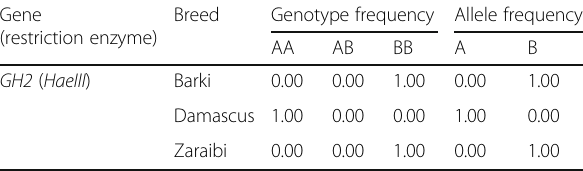
Table 3 Genotype and allele frequencies of GH2 - Hae III / RFLP Gene Breed Genotype frequency Allele frequency (restriction enzyme) AA